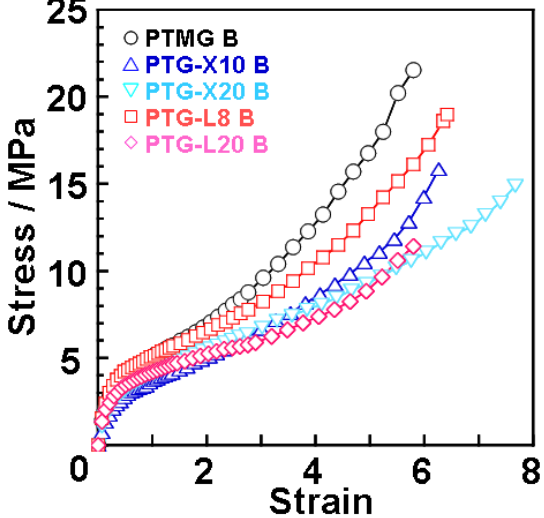
Figure 4. Stress-strain curves for PTMG, PTG-X, PTG-L-based PUEs measured at 20